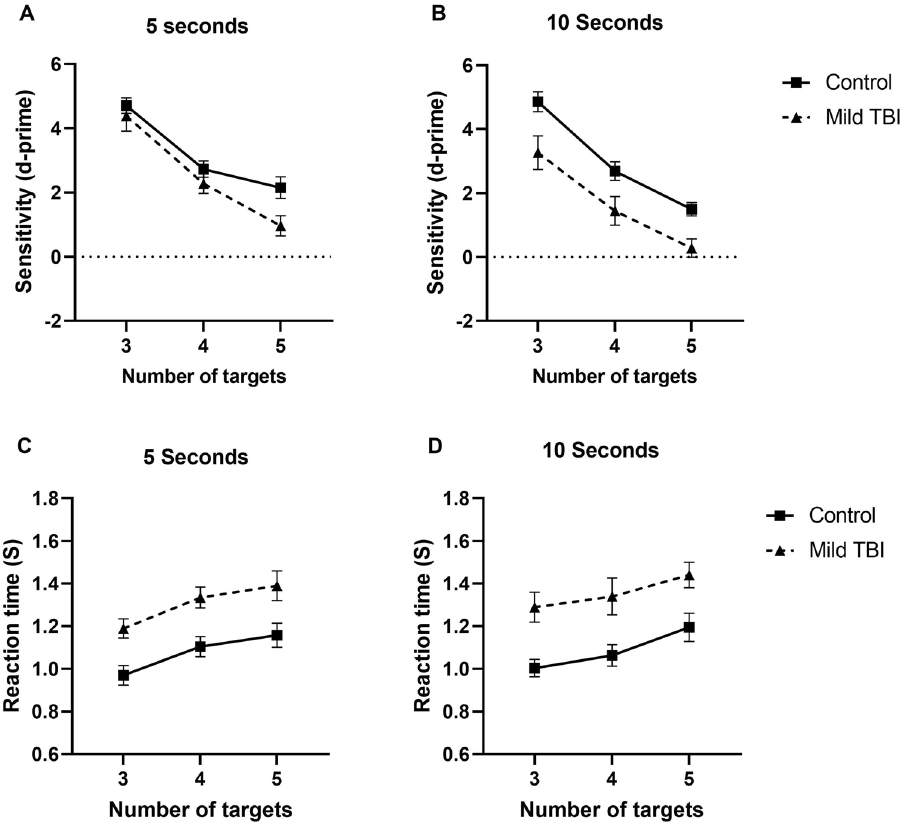
Figure 3. The sensitivity ( A , B ), and reaction time RT ( C , D ) as function of the number of targets to be tracked for control participants and patients with mild TBI (different symbols) for the tracking duration of 5 s (left panel) and 10 s (right panel). Error bars indicate 1 standard error of the